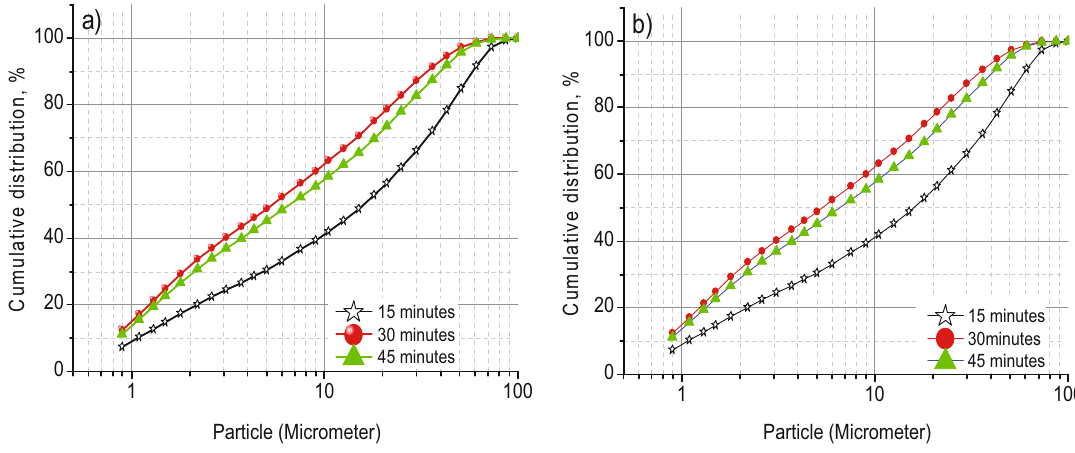
Figure 6: 30% BVT ( a ) and 30% GVT ( b ) blended types of cement ground at di ff erent durations.